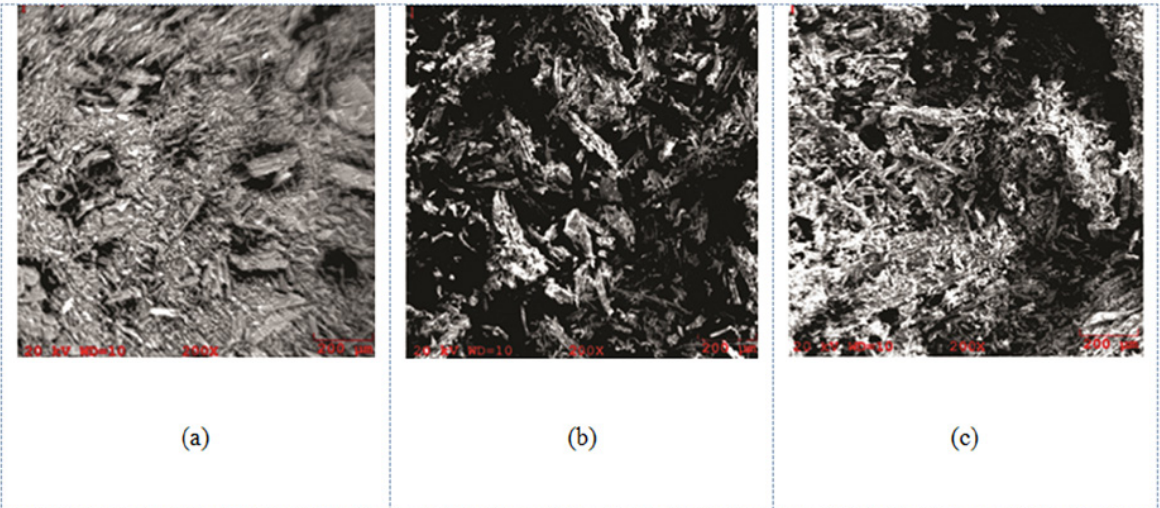
Table III. Surface area and Cation Exchange Capacity (CEC) of biochars. CBC 0.5FeBC 1.0FeBC CEC CEC CEC Surface area Surface area Surface area pH pH pH (m 2 g -1 ) (m 2 g -1 ) (m 2 g -1 ) cmol cmol cmol kg -1 kg -1 kg -1 c c c 1.0 37.4 1.0 382.6 1.0 347.8 2.0 34.8 2.0 373.9 2.0 278.3 2.309 9.338 28.758 3.0 36.0 3.0 374.2 3.0 295.6 4.0 34.6 4.0 417.4 4.0